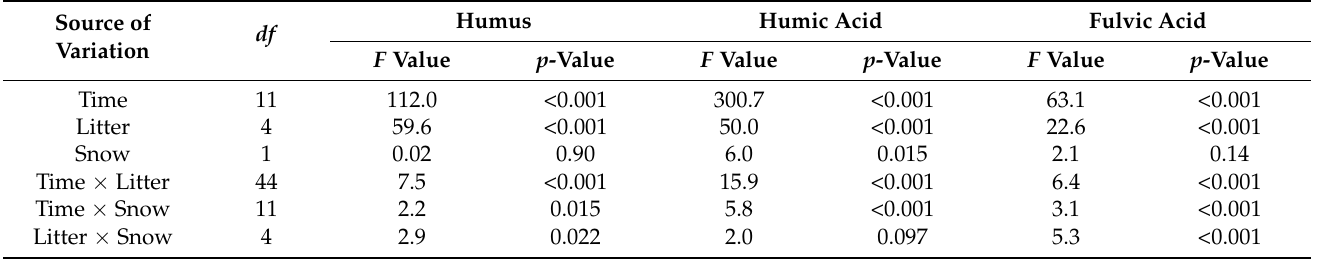
Table 3. Results of three-way ANOVA testing for the effects of time, litter species and snow manipu- lation. Bold values are significant ( p < 0.05).